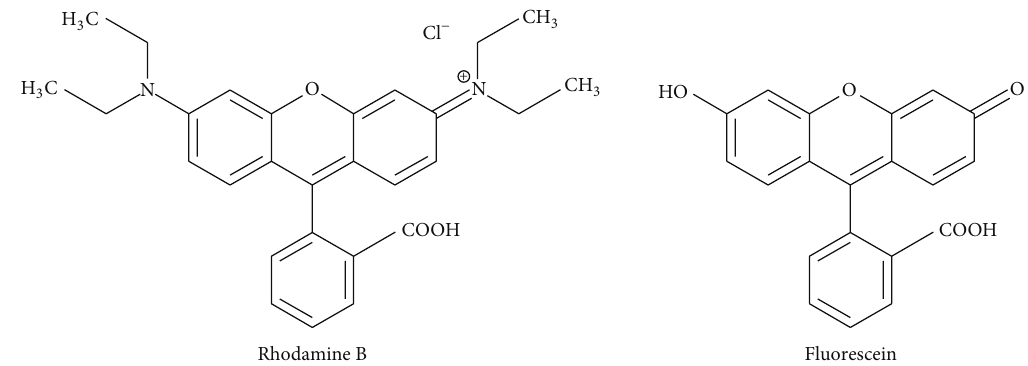
Figure 6: Chemical structures of rhodamine B and fluorescein.